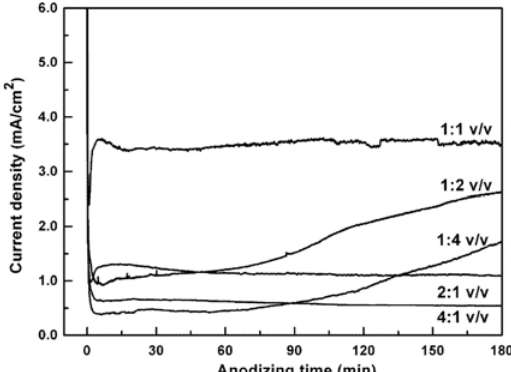
Figure 5. Current density-anodizing time curve for electrochemical anodization in the mixed solution containing glycerol and deionized water at different volumetric ratios at 10 V for 3 h. Reprinted from [38] with permission. Copyright (2013) Elsevier